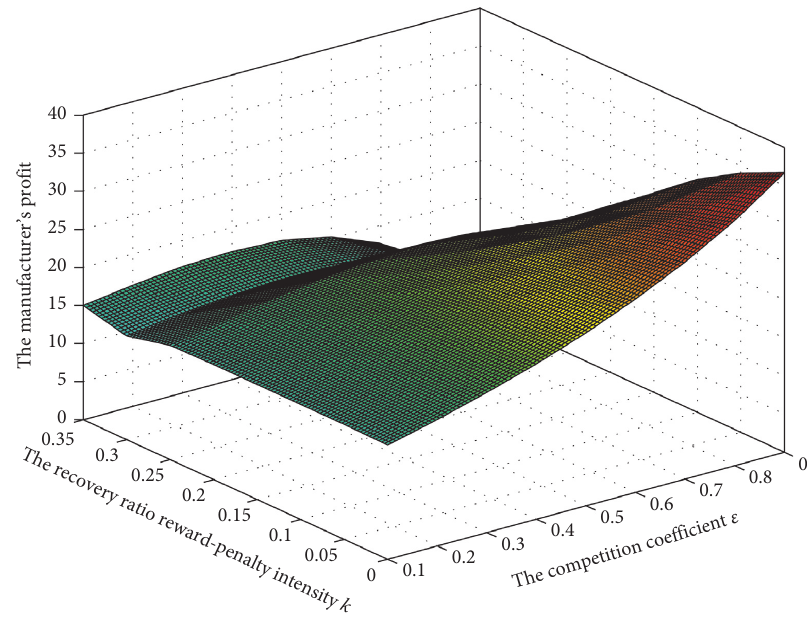
Figure 12: The manufacturer’s profit π